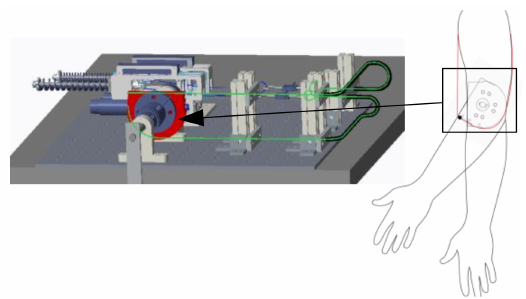
Figure 12. Design of rotating disk for simulating flexion and extension assist force